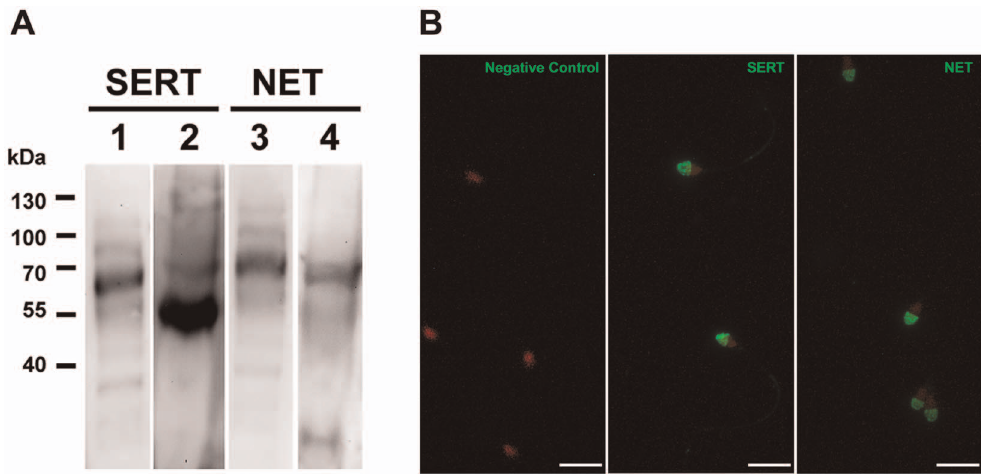
Figure 6. SERT and NET are present in ejaculated sperm. The presence and location of other monoamine transporters was determined in equine sperm. A) The presence of SERT and NET transporters were verified in equine sperm (line 2 and 4) by Western blot assays. A protein extract from whole rat brain (line 1 and 3) was used as a control. Images are representative of 3 independent experiments. B) The localization of SERT and NET was performed by indirect immunofluorescence assays. Images are representative of 3 independent experiments. Bar scale is 10 m m.